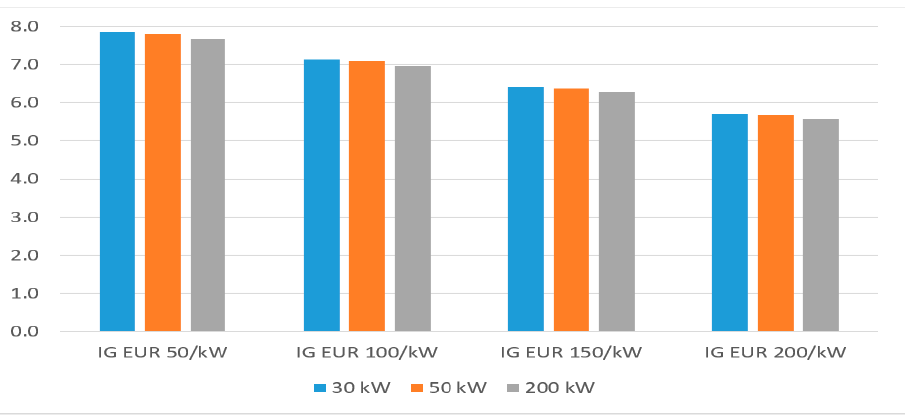
Figure 7. Simple payback period with net metering at various sizes of investment grants (IG) applied, years.